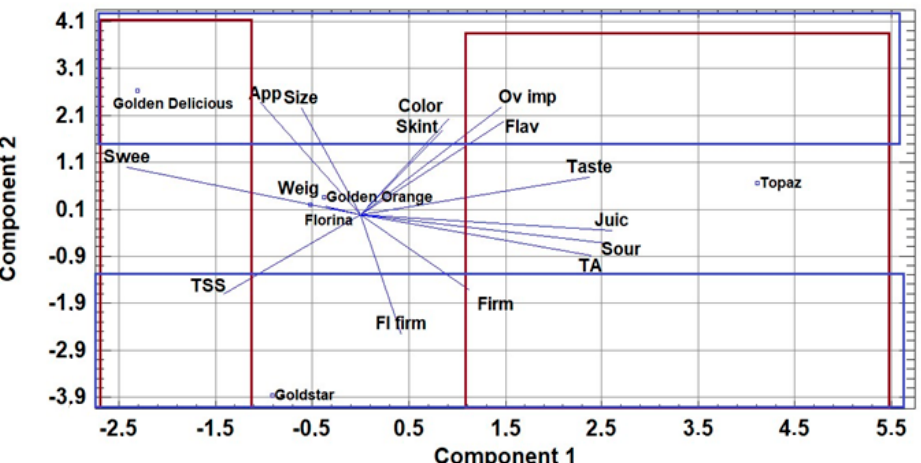
Figure 2. Principal component biplot of sensory and pomological attributes of different apple cul-